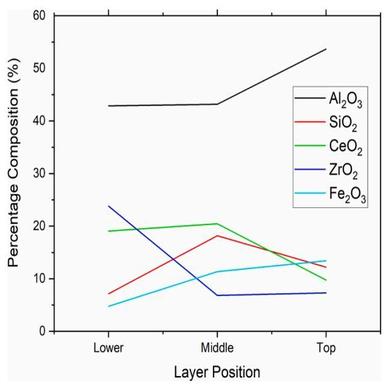
Variation of compositional analysis of the stratified melt pool along the height in the core catcher vessel.